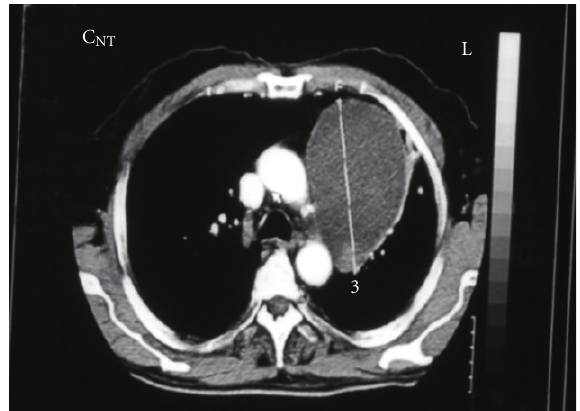
Figure 4: Computed tomography shows homogeneous cystic mass at the costosternal